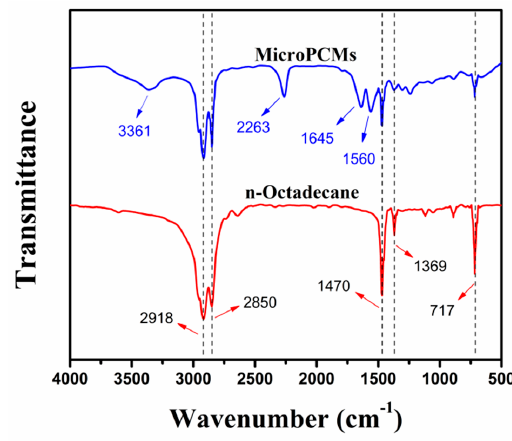
Figure 4. FTIR spectra of n ‐ octadecane and MicroPCMs.